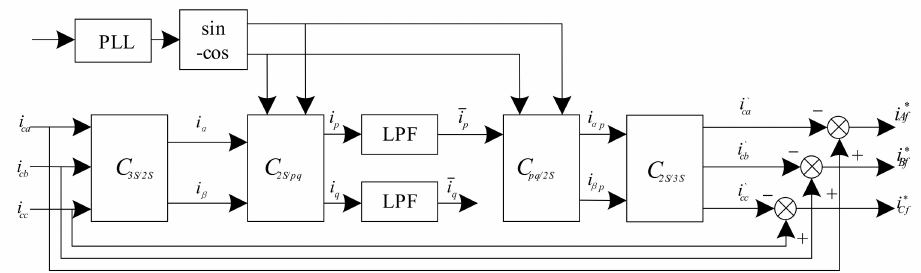
Figure 3. The reference current detection